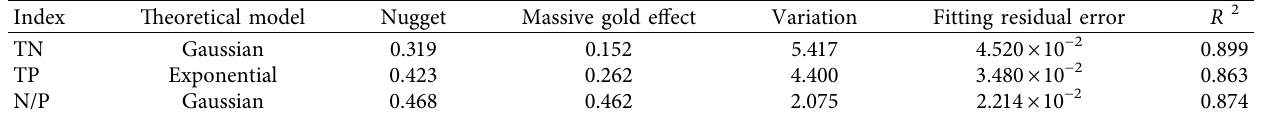
Table 2: Parameters of the semivariogram models for soil TN, TP contents, and N/P